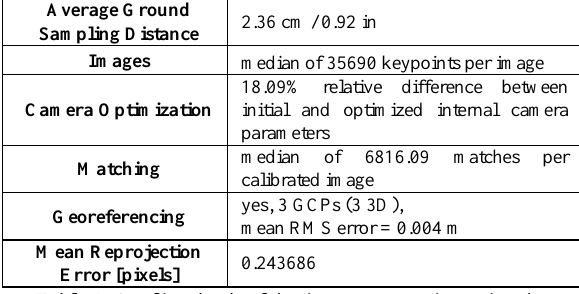
Table 3. Quality check of the image processing using the Drone2Map software